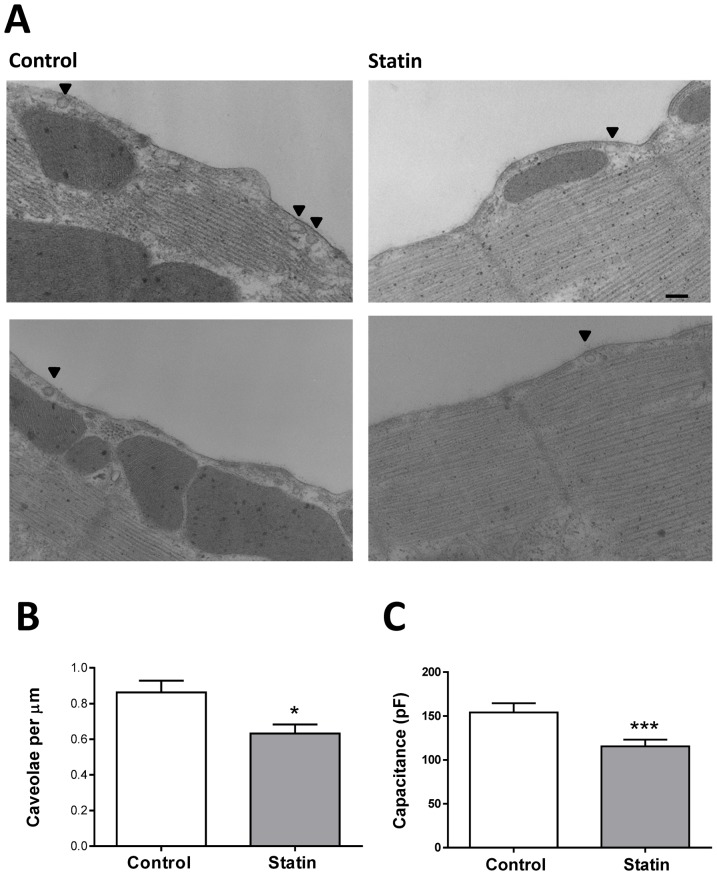
Simvastatin treatment reduces caveolar density.A. Representative membrane from control and simvastatin-treated cardiac myocytes. Arrows indicate caveolae. Scale bar represents 200 nm. B. Simvastatin treatment reduced the mean density of caveolae measured in ≈330 µm of membrane (n = 9 myocytes from 3 hearts). * P<0.05, Student's t-test. C. Simvastatin treatment reduced cell capacitance (n = 27–33 cells from 19 hearts). *** P<0.001 Mann Whitney Rank test.